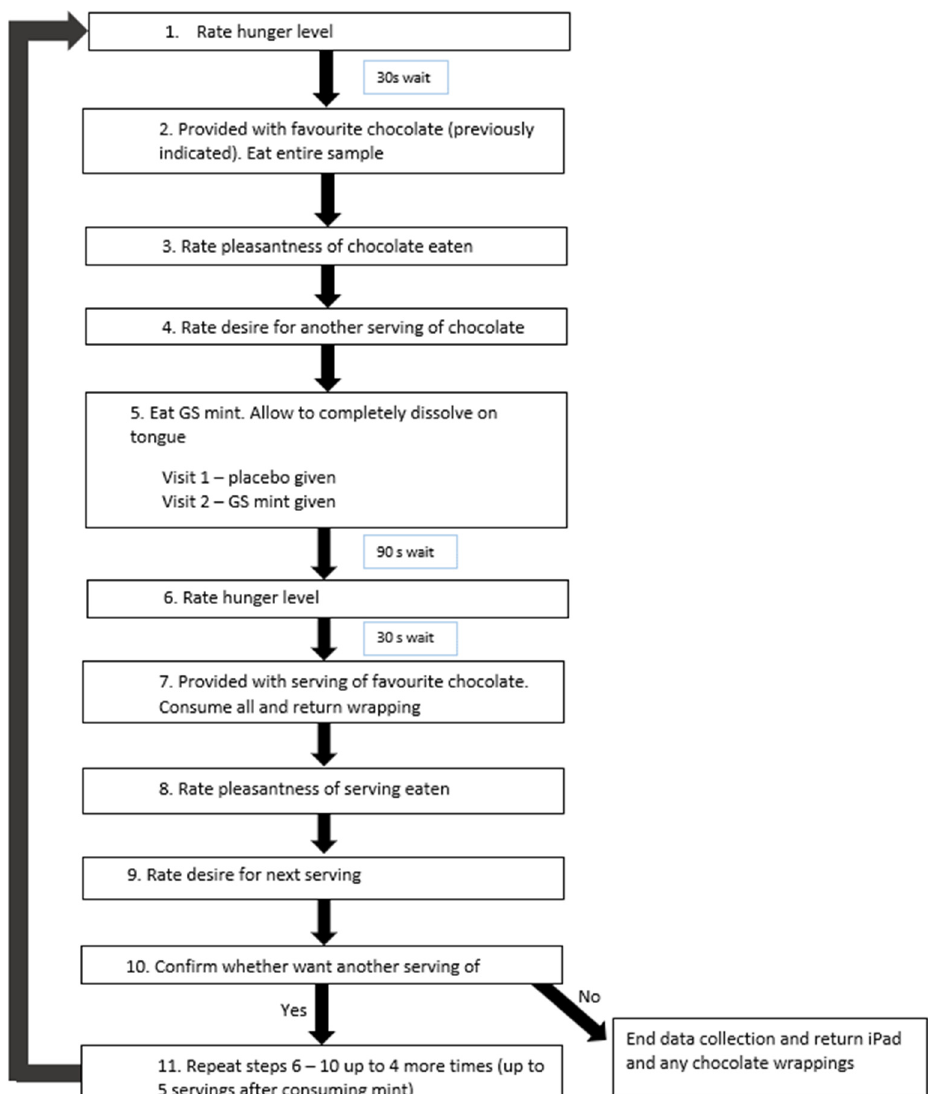
Figure 1. Flow diagram of research procedure.